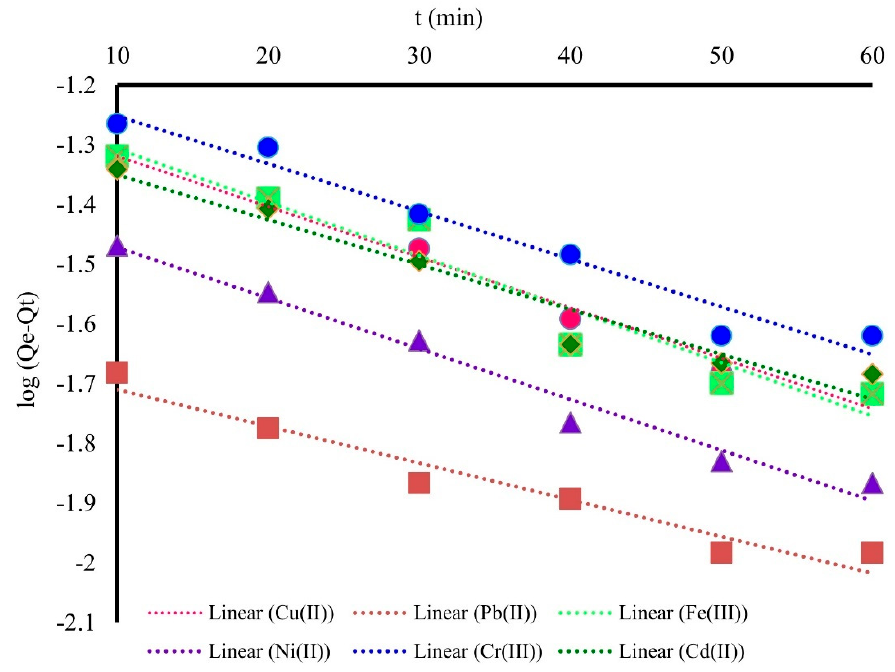
Figure 5. Graphical representation of pseudo-first-order kinetic model. Table 3. Pseudo-first-order model constants for adsorption of M X+ onto